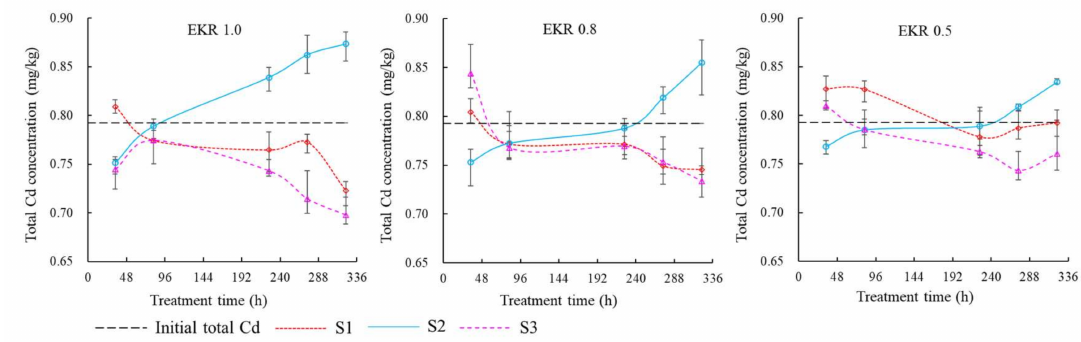
Figure 5. Total Cd concentration variation under different voltage